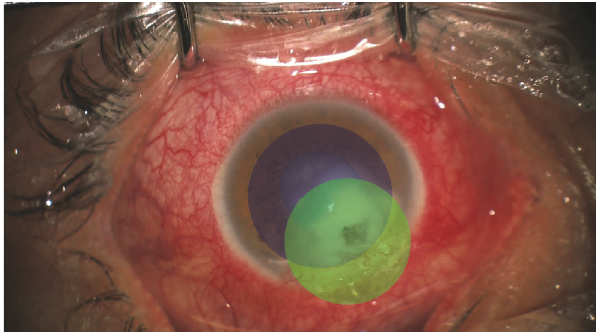
Figure 5: Clinical appearance of the patient three weeks after surgery. Note some natamycin over the eye.